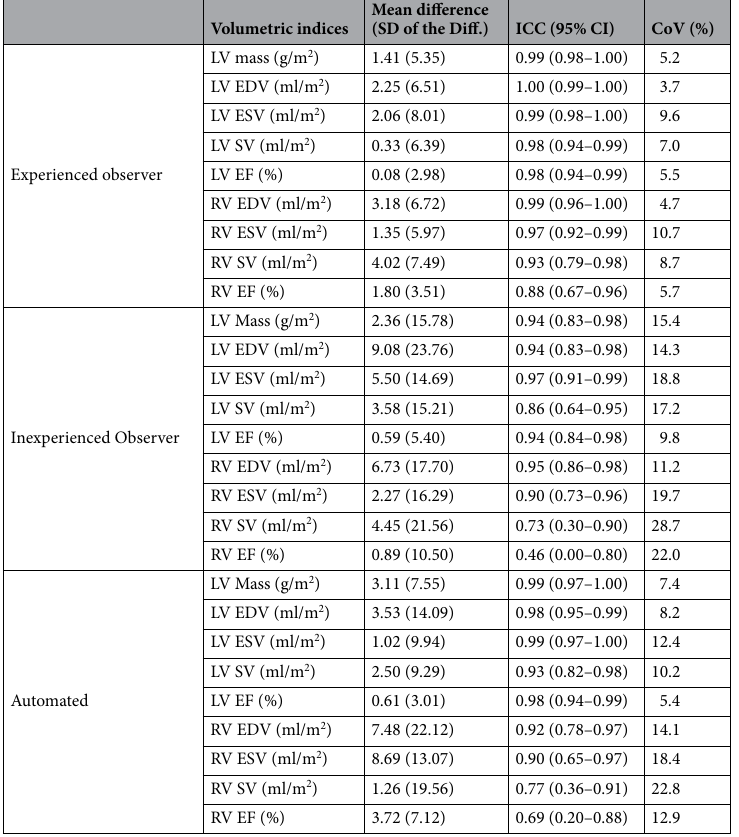
Table 2. Interstudy reproducibility. Interstudy variability for manual (experienced and inexperienced observer) as well as for fully automated assessments. LV mass is reported in gram, volumes in ml and EF in %. SD standard deviation, ICC intraclass correlation coefficient, CoV coefficient of variation, LV left ventricular, RV right ventricular, EDV end-diastolic volume, ESV end-systolic volume, SV : stroke volume, EF ejection